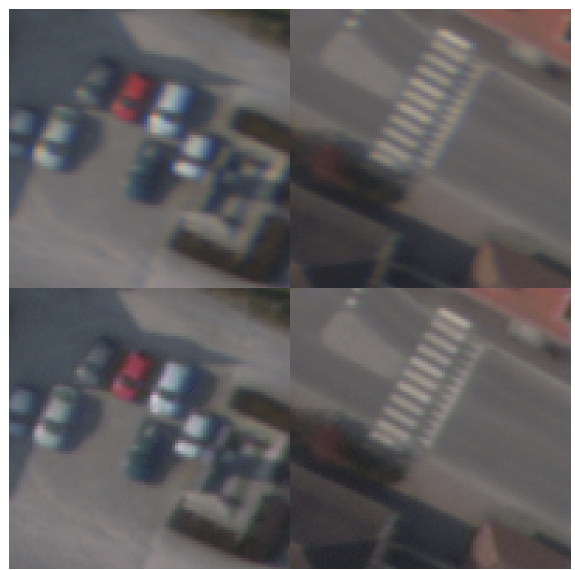
Figure 8. Result of the blur correction step using the pansharpening approach. Top: the original image. Bottom: the restored